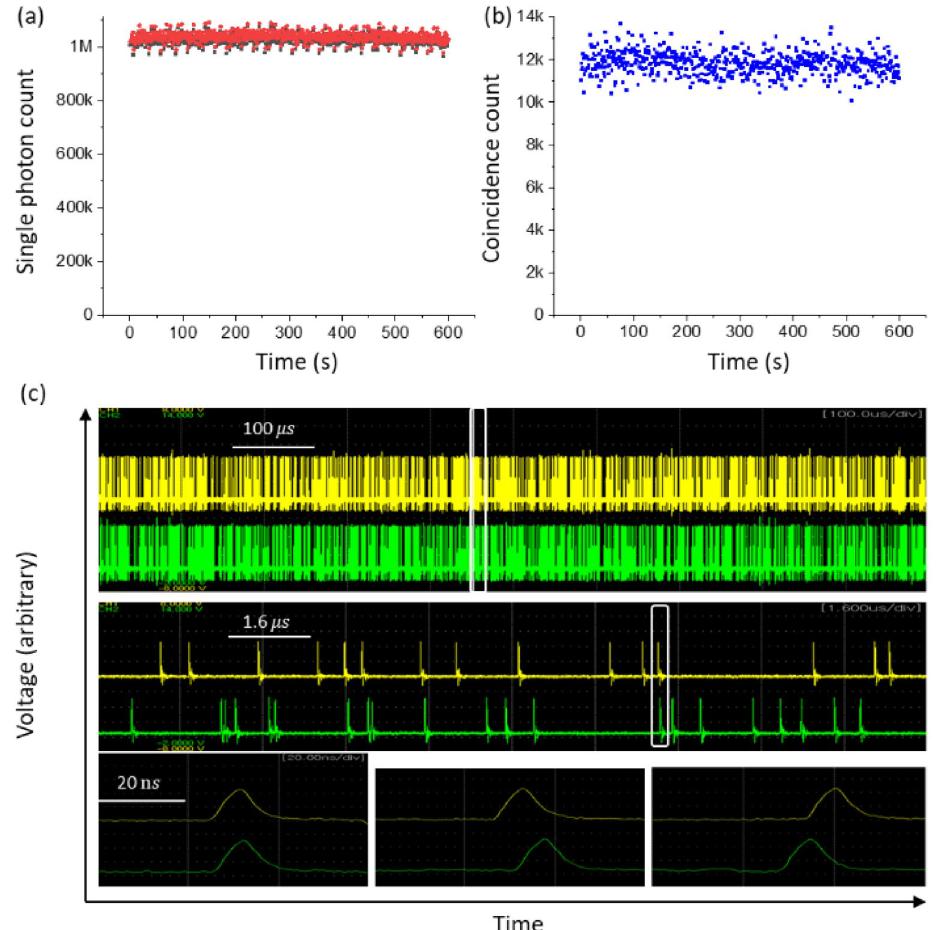
Figure 2. Attenuated photon statistics. ( a ) Single photons counted by CCU via D1 (red) and D2 (black), where D2 is relocated between BS1 and BS2 in Fig. 1 (see the text). ( b ) Coincidence detection counts. ( c ) On the oscilloscope. (Top panel) Corresponding single photon streams for ( a ). Yellow/green: D1/D2. (Middle panel) Expansion of the white box in the Top panel. (Bottom panel) Expansion of the white box in the Middle panel (see the